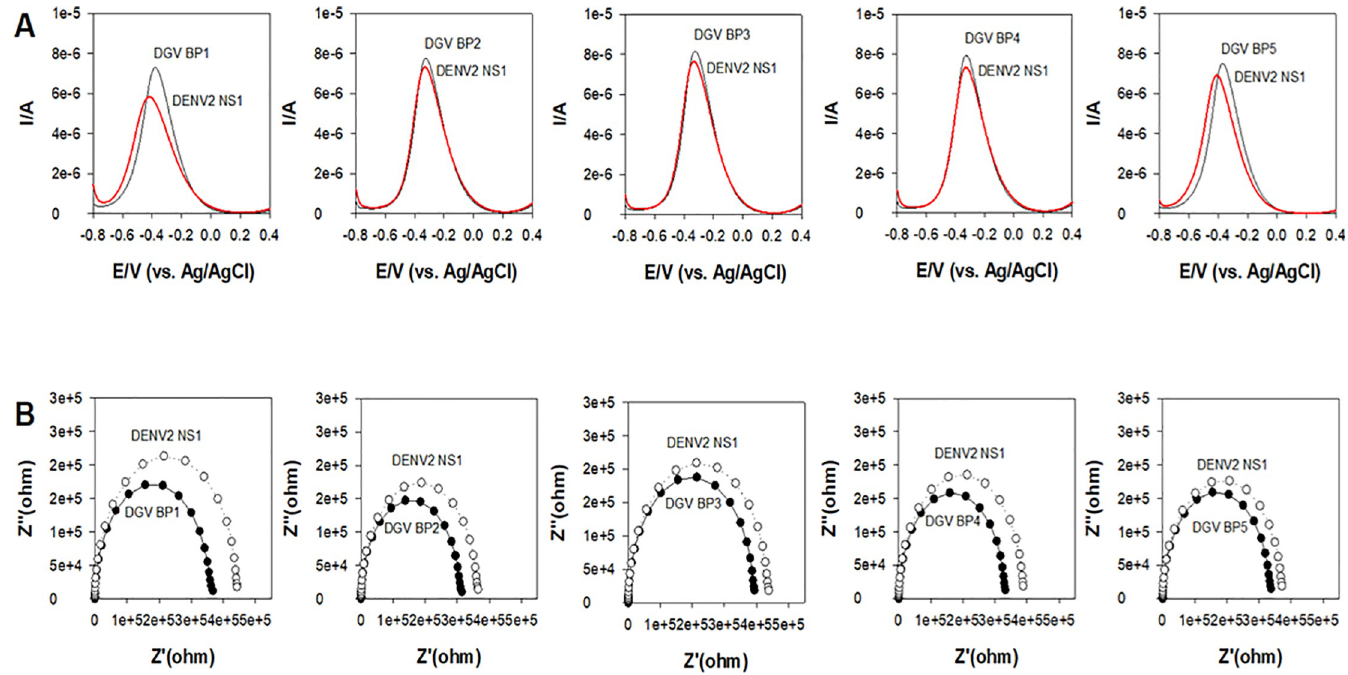
Fig 3. Relative binding affinities of five synthetic peptides (DGV BP1–5), determined by square wave voltammetry (SWV) measurements of dengue virus (DGV) type 2 nonstructural 1 (NS1) proteins (denoted DENV2 NS1, 12.5 μ g/mL). A series of synthetic peptides were immobilized onto a gold surface and the current change was measured by